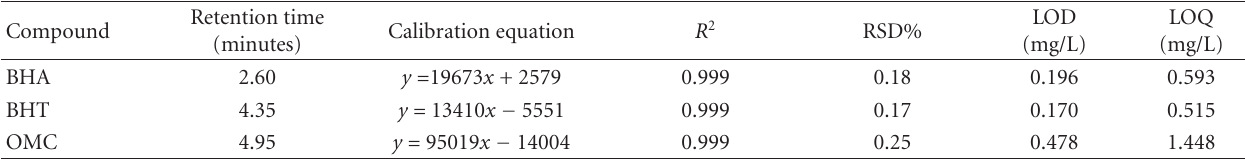
Table 3: Validation of analytical method for BHA, BHT, and OMC by RP-HPLC-UV/Vis.